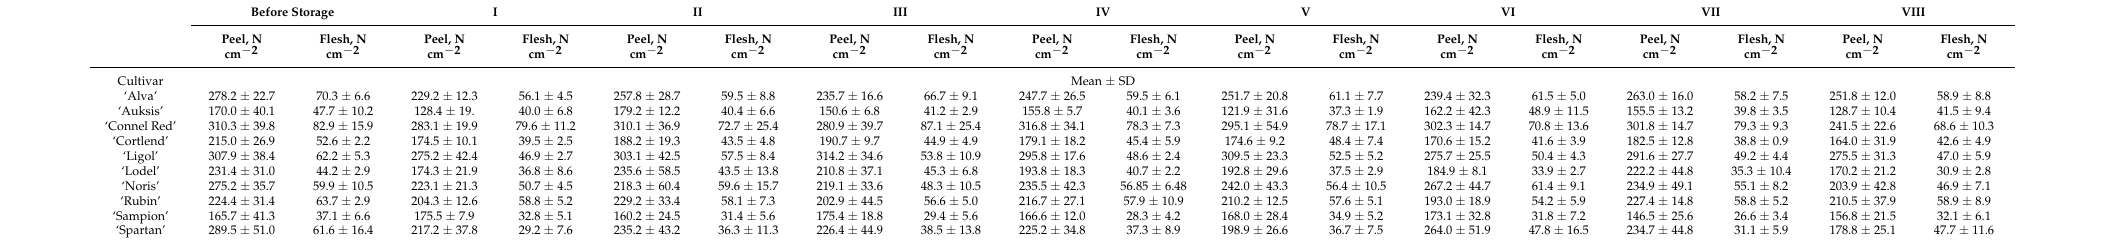
Table 5. Variability of the firmness indicators in apple peel and flesh samples before and after storage in